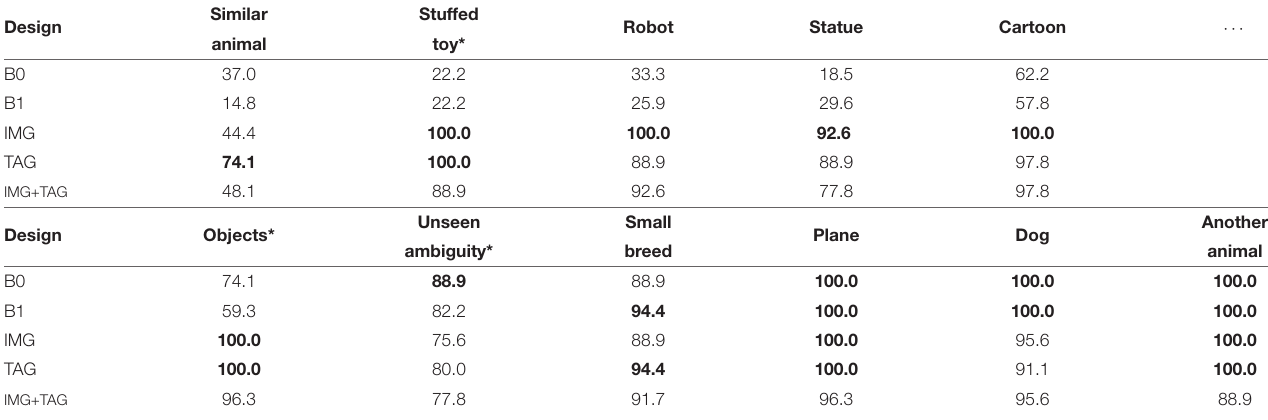
TABLE 3 | Worker accuracy [%] on Task 1b, broken down by concept category. Design